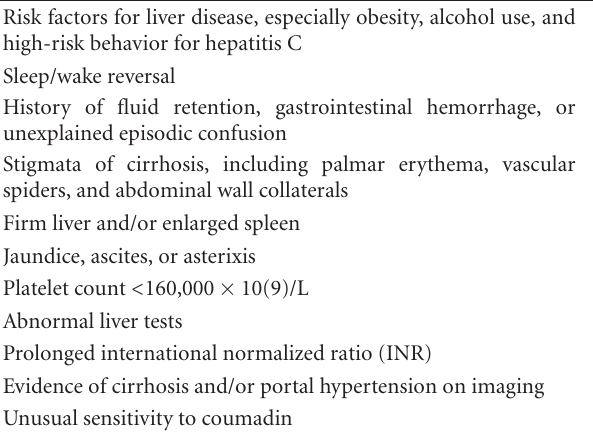
Table 1: Clues to the presence of cirrhosis. Risk factors for liver disease, especially obesity, alcohol use, and high-risk behavior for hepatitis